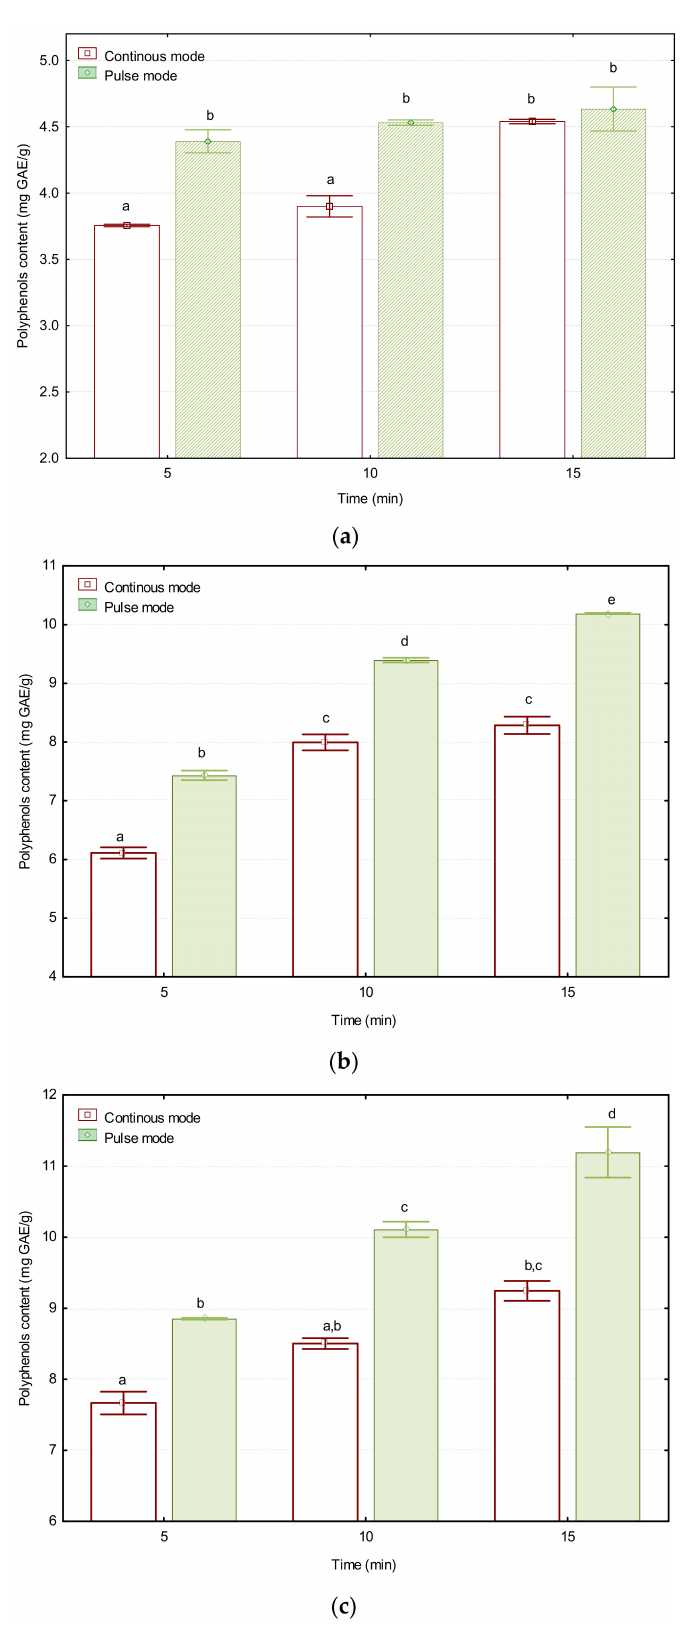
Figure 1. Effect of ultrasonic treatment parameters on the content of polyphenols (mg GAE/g d.m.) in hawthorn berries extracts: ( a ) amplitude 12 µ m, ( b ) amplitude 24 µ m, ( c ) amplitude 36 µ m. The bars marked with the same letter are not statistically significantly different ( p <